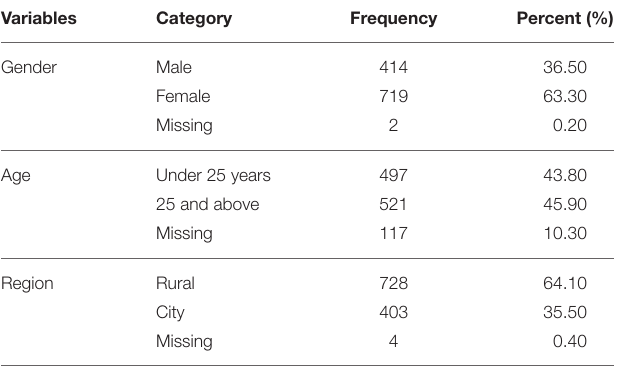
TABLE 1 | Demographic characteristics ( N =